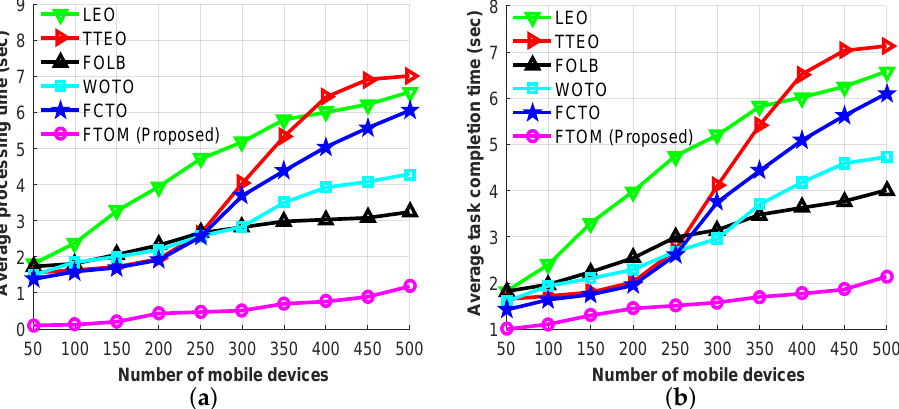
Figure 11. Performance evaluations based on all application types: ( a ) average processing times; ( b ) average task completion